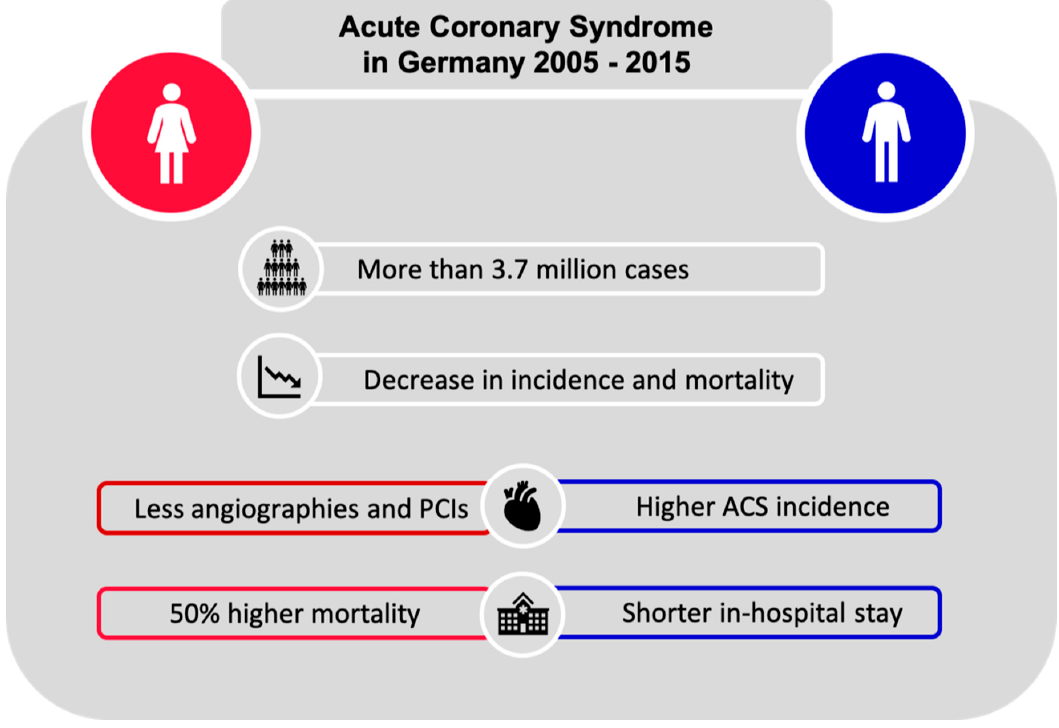
Figure 3. Central illustration summarizing main study results.